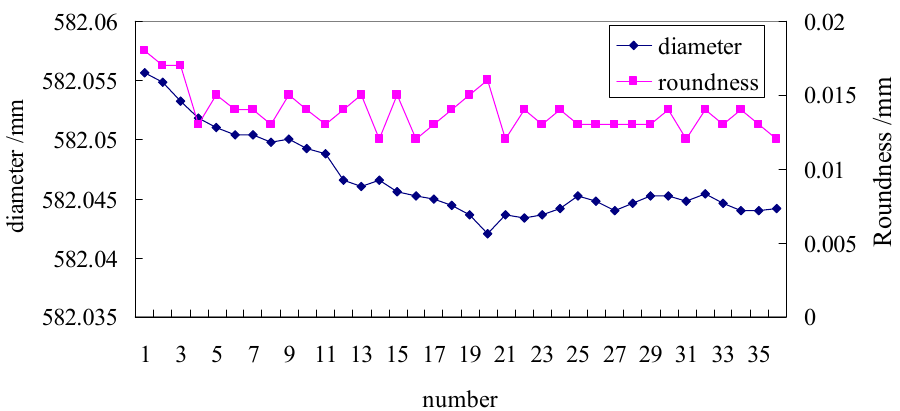
Figure 5. Repeatability of the measurement